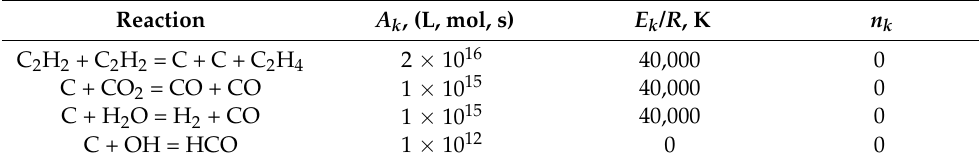
Table 1. Macrokinetic mechanism of soot